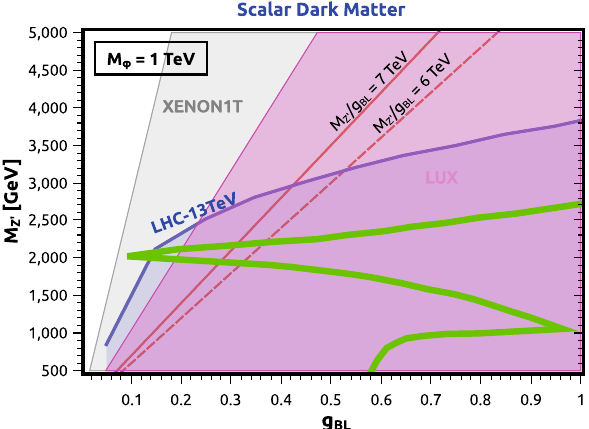
Fig. 13 Allowed region of parameters for a 2 TeV scalar field as dark matter. The green curve delimits the region of parameter space with the right abundance ( (cid:2) h 2 = 0 . 11 − 0 . 12), the pink ( gray ) shaded region is ruled out by LUX2016 (XENON1T), the blue region is excluded by dilepton data from the LHC, and the solid red ( dashed ) lines rep- resent the current (old) LEP-II bounds, namely M Z (cid:2) / g BL > 7 TeV ( M Z (cid:2) / g BL > 6 TeV)